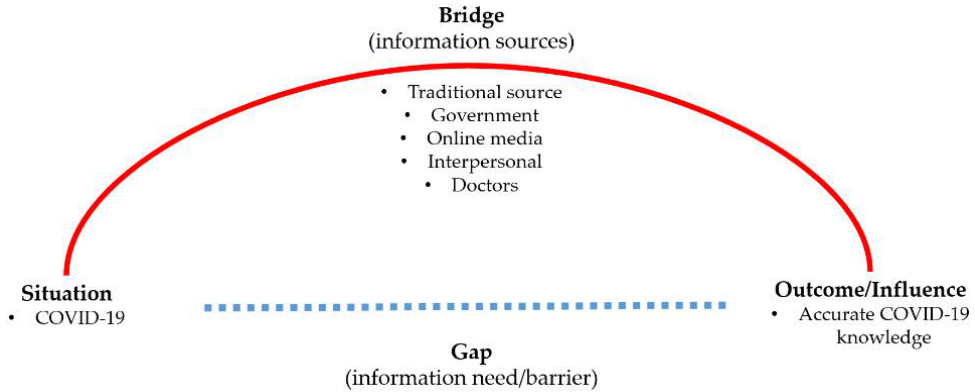
Figure 1. Conceptual Framework of the Study.